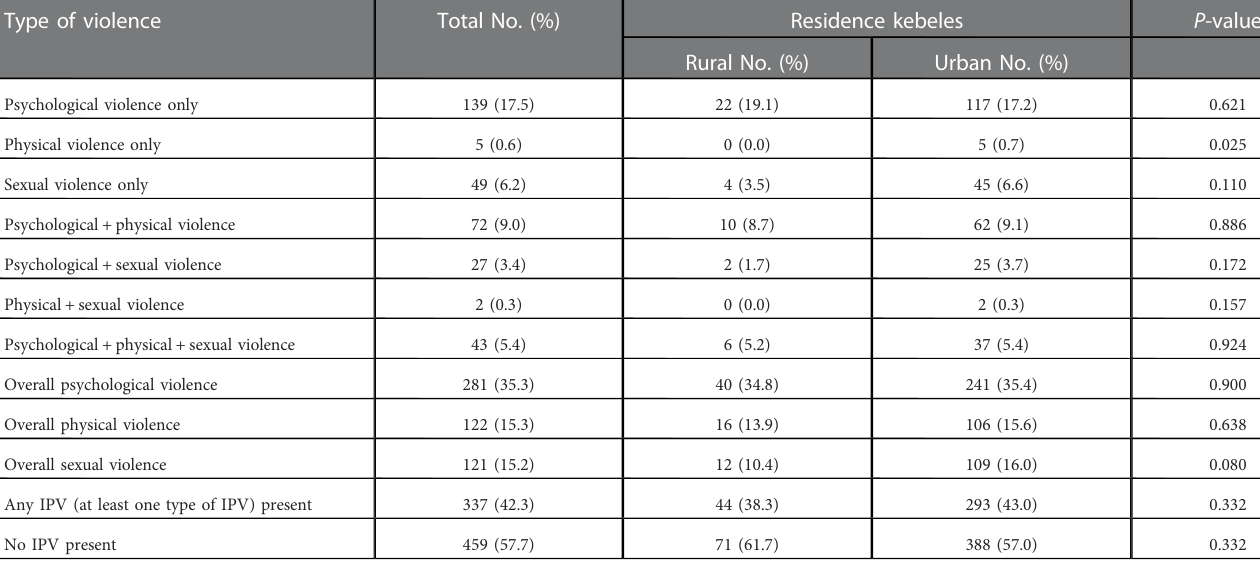
TABLE 4 Prevalence of intimate partner violence in women of reproductive age in Debre Berhan, Ethiopia, 2021 ( n =796). Type of violence